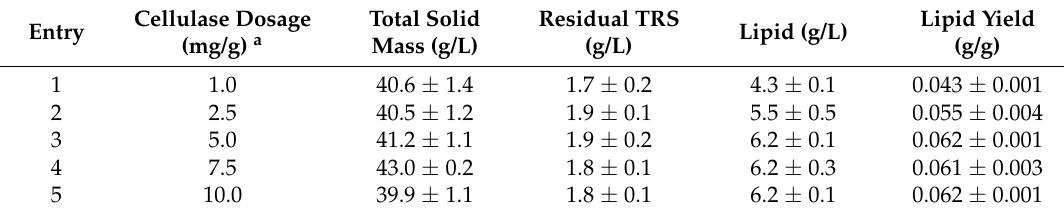
Figure 1. Total reducing sugar (TRS) ( a ) and glucose ( b ) evolution profiles of lipid production at 37 ◦ C with various amounts of cellulase. Table 1. The results of lipid production from DryPB corn stover at 37 ◦ C with various amounts of